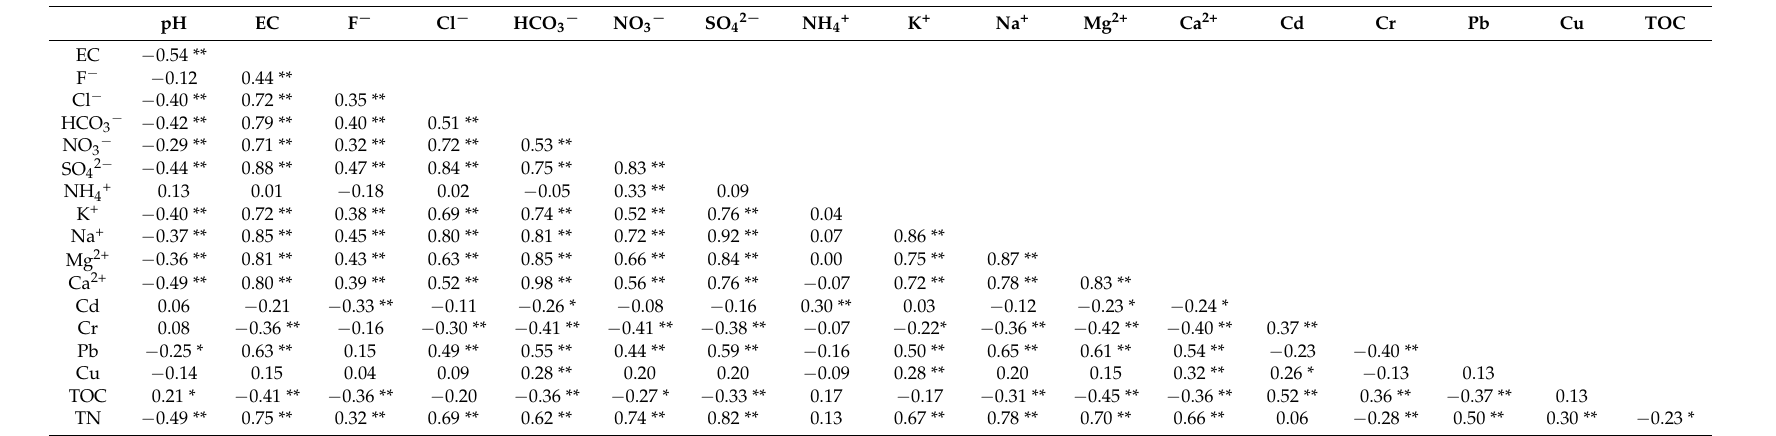
Table 5. Correlation Coefficient of MEs for DW in the five major cities, NW,